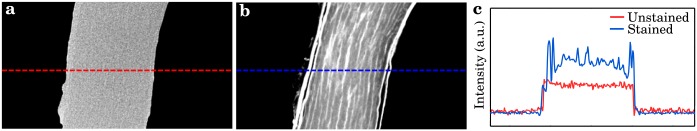
Contrast-enhanced micro-CT imaging.(a) Micro-CT section of an unstained and (b) an iodine-stained optic nerve. In the case of the unstained optic nerve (control) none of the anatomical substructures were distinguishable with micro-CT, since density variations within soft tissue are very low and thereby intrinsic X-ray contrast is small. Using a multiple-stage iodine staining procedure, the characteristic myeline-covered nerve fiber bundles, the septa as well as the dura mater, pia mater and the subarachnoid space became clearly discernable, due to a selective uptake of contrast-rich iodine. Both volumes were acquired with the same imaging parameters. (c) Corresponding line-plots of the intensity values through the tomographic slices visualizing a strongly enhanced overall and local contrast in case of the iodine-stained nerve. Both curves are not true to scale.